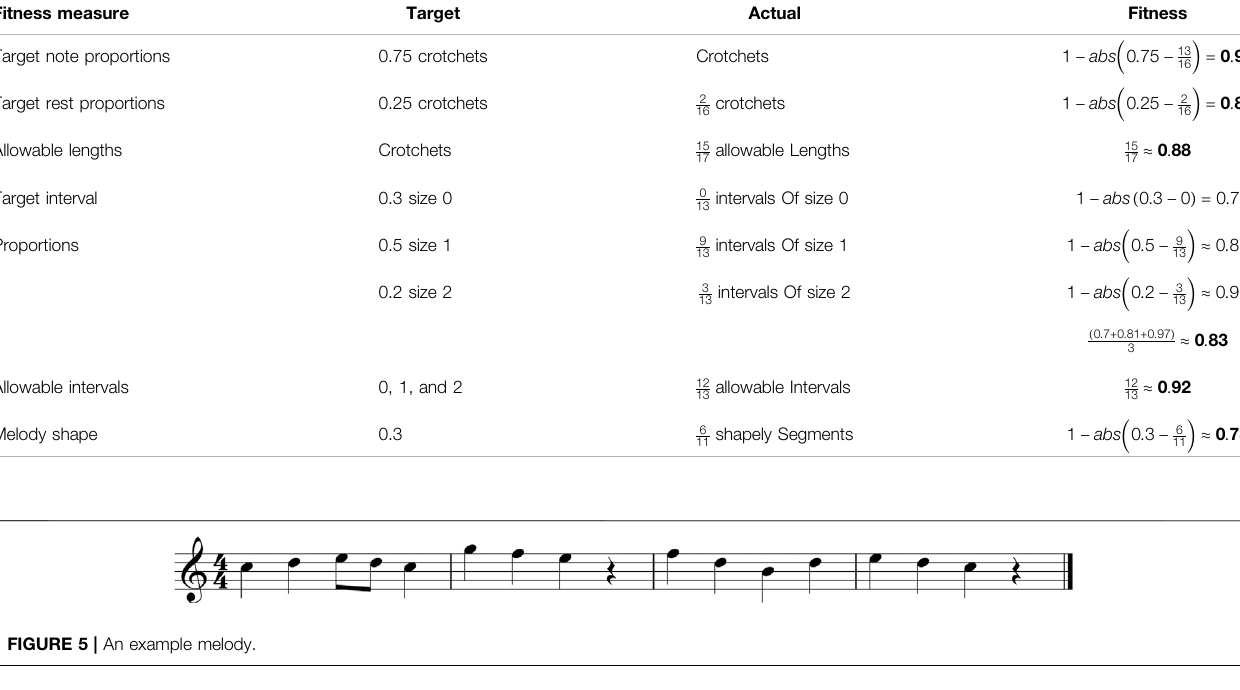
TABLE 3 | Calculating the fi tness of the melody in Figure 5 against an arbitrarily selected set of targets. The fi nal fi tness value for each measure is in bold. Fitness measure